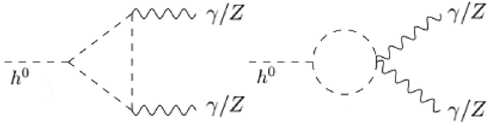
Figure 1 . NP scalar one-loop contributions to Higgs to neutral diboson decays. The new scalar is represented by the unlabeled dashed